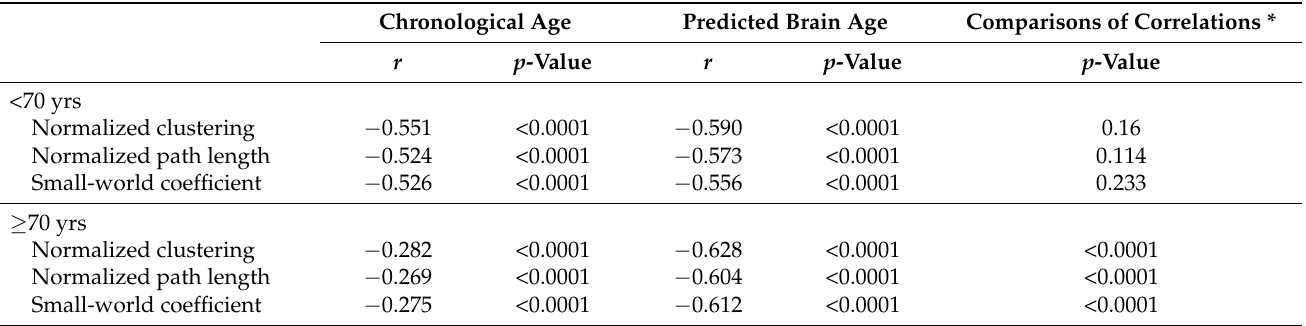
Table 4. Partial correlations of network properties with chronological/predicted brain age in partici- pants < 70 and ≥ 70